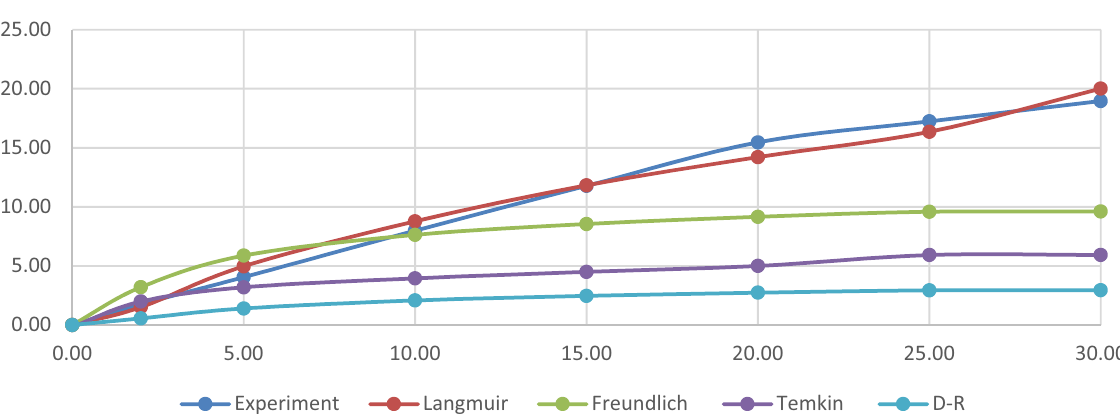
Figure 5. Linear curves and non-linear of the isotherm models of fluoride adsorption on the bivalve shell under the optimized